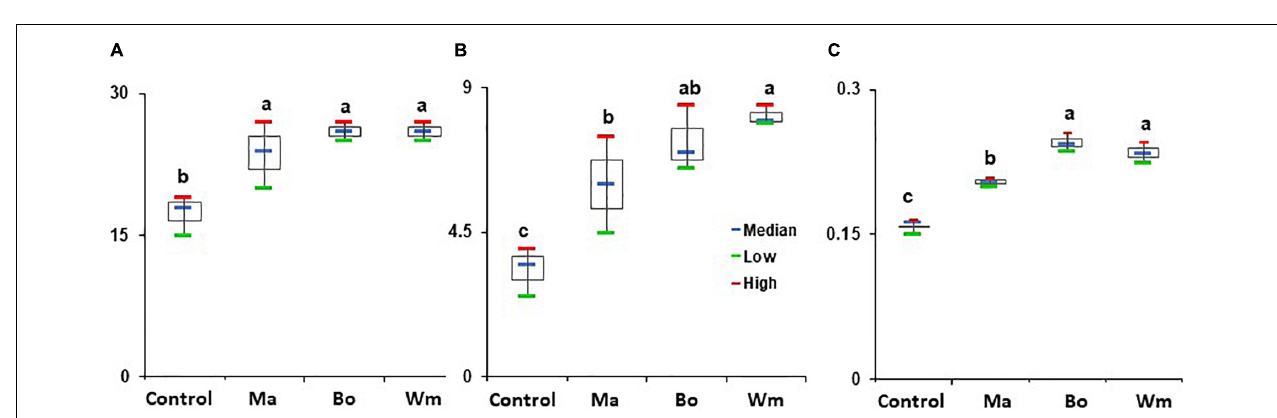
FIGURE 7 | Growth promotion of Arabidopsis by treatment of bacterial strains isolated from rice seeds. Arabidopsis thaliana Col-0 seeds were surface-sterilized and bacterized by soaking in the bacterial suspension of (A) Bacillus oceanisediminis , (B) Methylobacterium aquaticum , and (C) Williamsia muralis . (D) The seeds treated with sterile DW amended with 0.2% CMC served as control. The bacterized seeds were sown onto 1/2 MS medium and cultured in plant-growth chambers. The photos were taken 10 days after incubation.